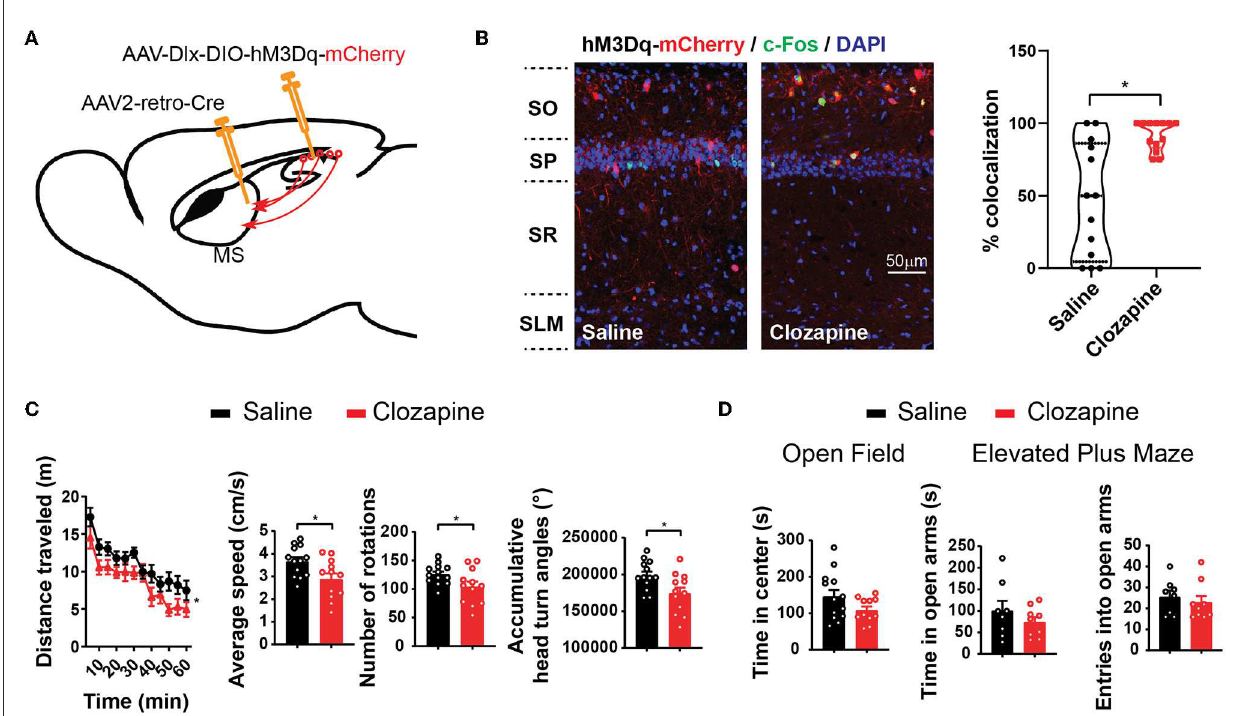
FIGURE3 Activation of septum-projecting interneurons reduces locomotion. (A) Expression of hM3Dq in septum-projecting hippocampal GABAergic interneurons by AAV injections. (B) Intraperitoneal injections of clozapine (0.1 mg/kg), a ligand of hM3Dq, increased activity of septum-projecting hippocampal GABAergic interneurons measured by double labeling of c-Fos (green) and mCherry (red) (saline, n = 13 sections, total 62 cells from two mice; clozapine, n = 13 sections, total 73 cells from two mice) (Mann–Whitney U -test, * p < 0.05). (C) Activation of the septum-projecting hippocampal GABAergic interneurons with clozapine decreased mouse locomotion measured by the distance traveled in the open field, number of rotations, and accumulative head turn angles [two-way ANOVA, F (1,23) = 6.35, p < 0.05; Two-tailed t -test, * p < 0.05]. (D) Activation of the septum-projecting hippocampal GABAergic interneurons did not change time spent in the center of the open-field test (two-tailed t -test, p = 0.1), time spent in the open arms (two-tailed t -test, p = 0.31), and the number of entries into the open arms of the elevated plus maze test (two-tailed t -test, p = 0.55) (open field: saline: n = 13; clozapine: n = 11. Elevated plus maze: saline: n = 8; clozapine: n =